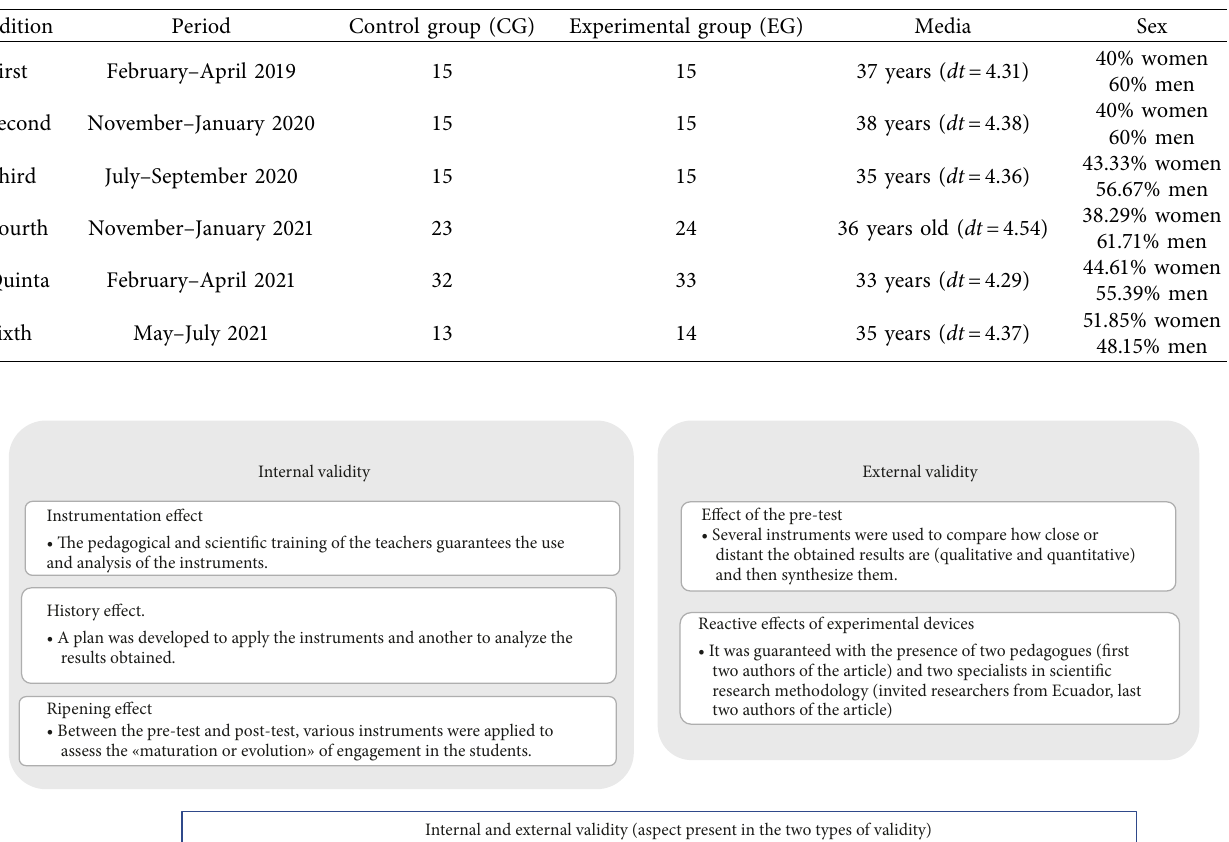
Table 1: Distribution of the sample.